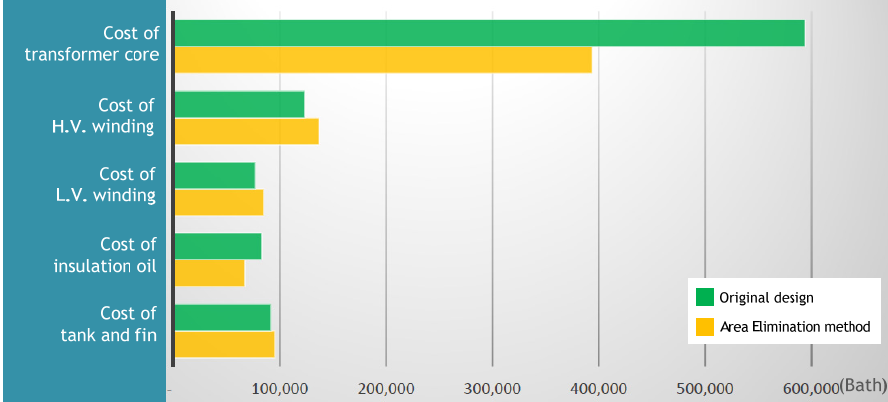
Figure 15. The cost comparison between the original design and Area Elimination method.